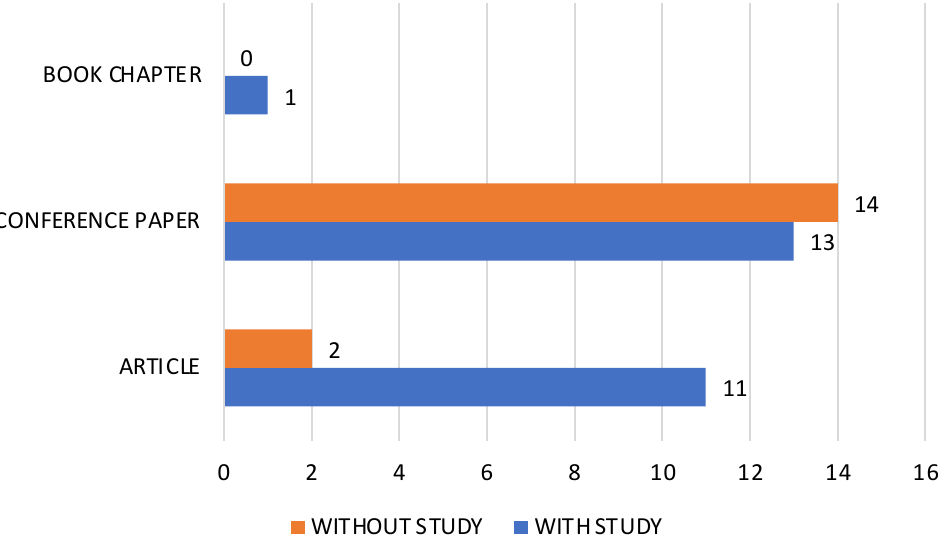
Figure 5. Type of documents analyzed, differentiating those that containing some type of empirical study from those that do not include any.